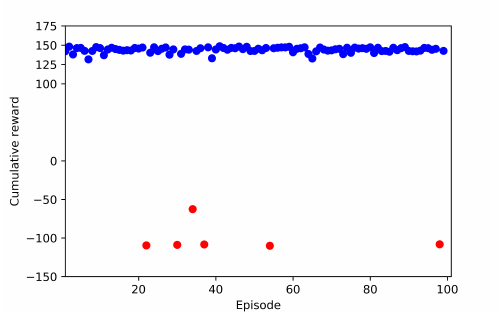
Figure 39. Test Result for Case 2.2 (With